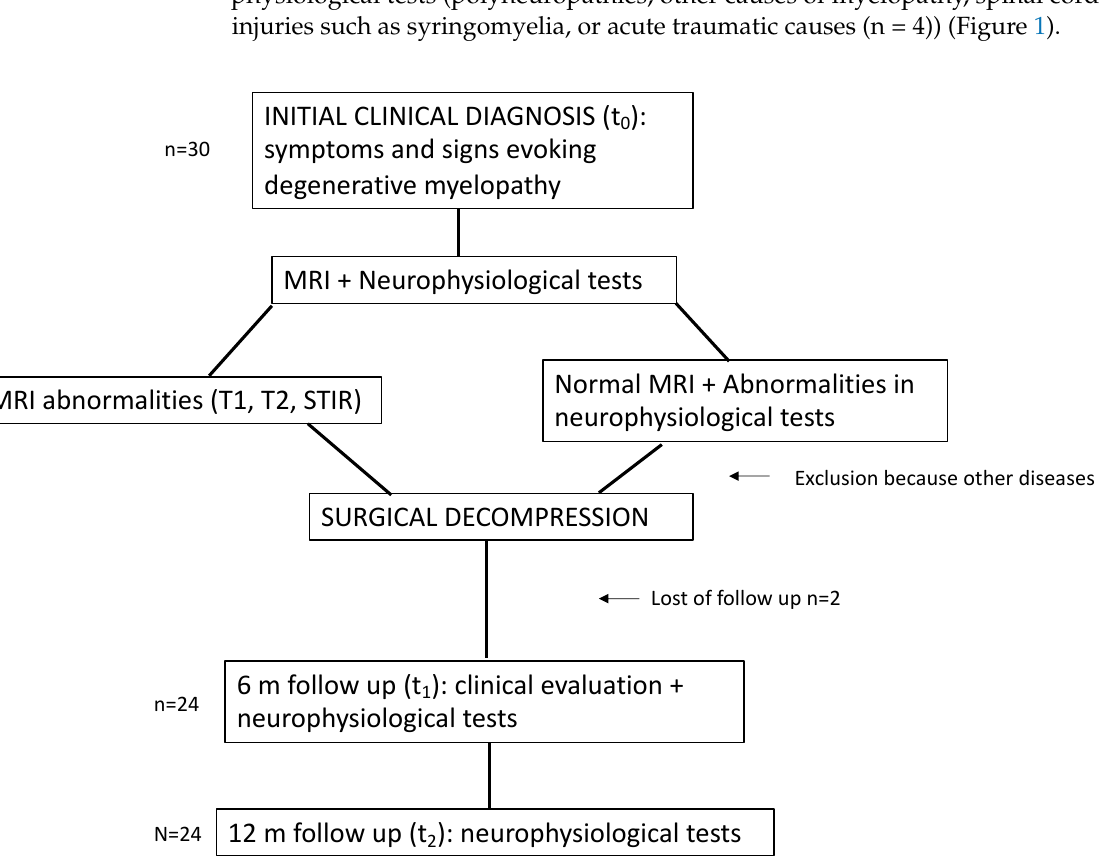
Figure 1. Flowchart of the diagnostic process, surgical treatment, and follow-up.